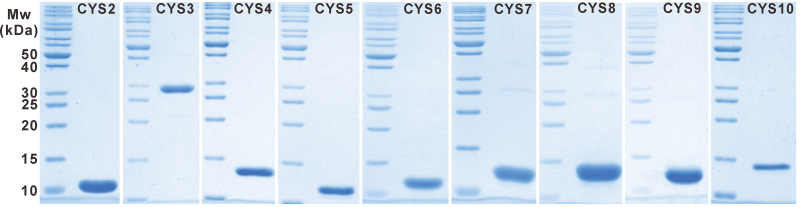
Purification of tobacco cystatins. Coomassie blue-stained SDS–polyacrylamide gel showing purified cystatins.